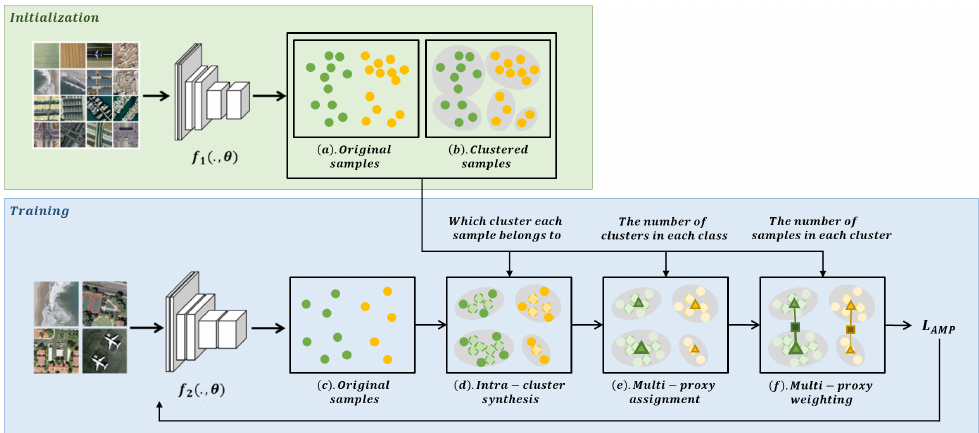
Figure 3. The AMP method framework. The top half of the figure is the initialization module, and the backbone network maps the sample features into the embedding space, as shown in ( a ). The yellow and green in the figure represent two classes of samples, the gray-shaded parts are the clusters after performing the clustering algorithm, as show in ( b ). The lower half of the figure represents the training phase. ( c ) shows the initial training data in a batch. We synthesize the samples intra-cluster within the batch based on the information obtained in the initialization phase, and the dashed border indicates the synthesized samples, as shown in ( d ). After the synthesis phase, we assign a proxy to each cluster to express the intra-cluster features. The triangle in ( e ) represents the proxy, the square in ( f ) represents the overall features of the class, and the thickness of the line between the square and the triangle represents the weight of the